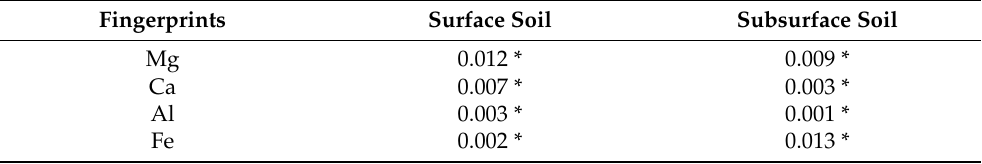
Table 7. Geochemical fingerprints (mg/kg) that satisfied the pairwise multiple comparison